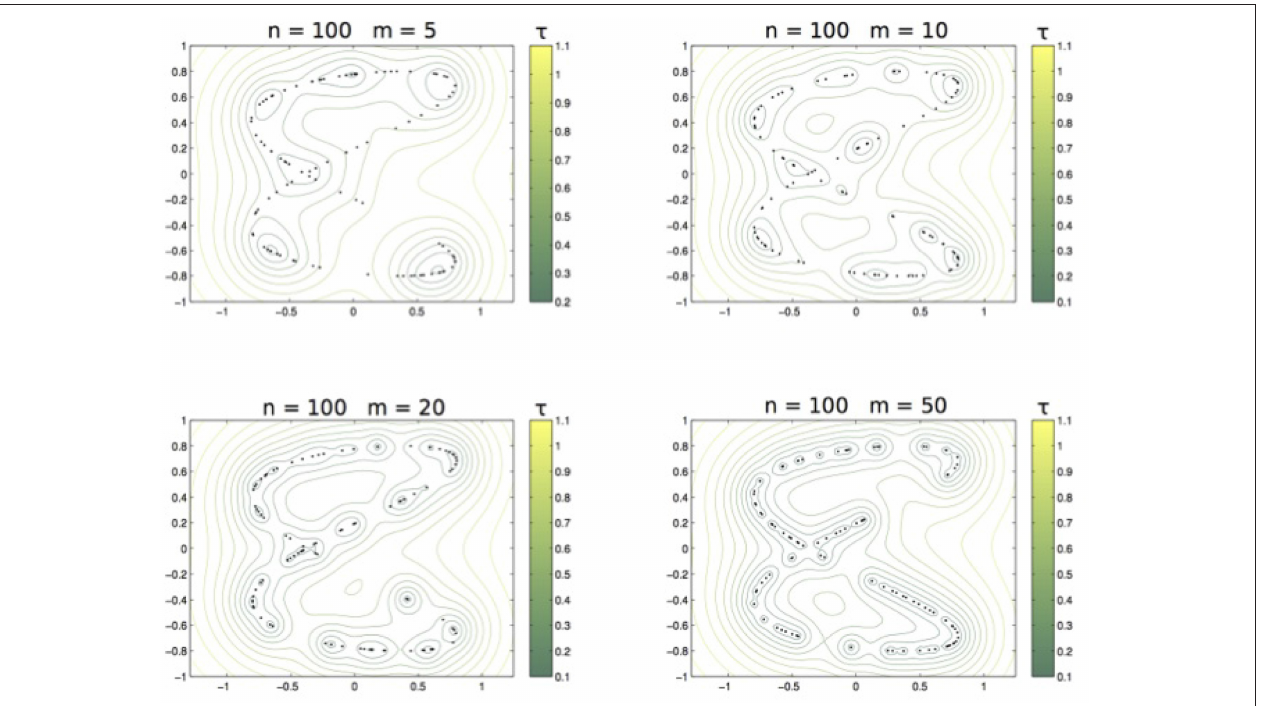
FIGURE 6 | From left to right and top to bottom: The family of sets ˆ C 5, τ 100 , ˆ C 10, τ 100 , ˆ C 20, τ 100 , ˆ C 50, τ 100 with τ varying as in the related colorbar.